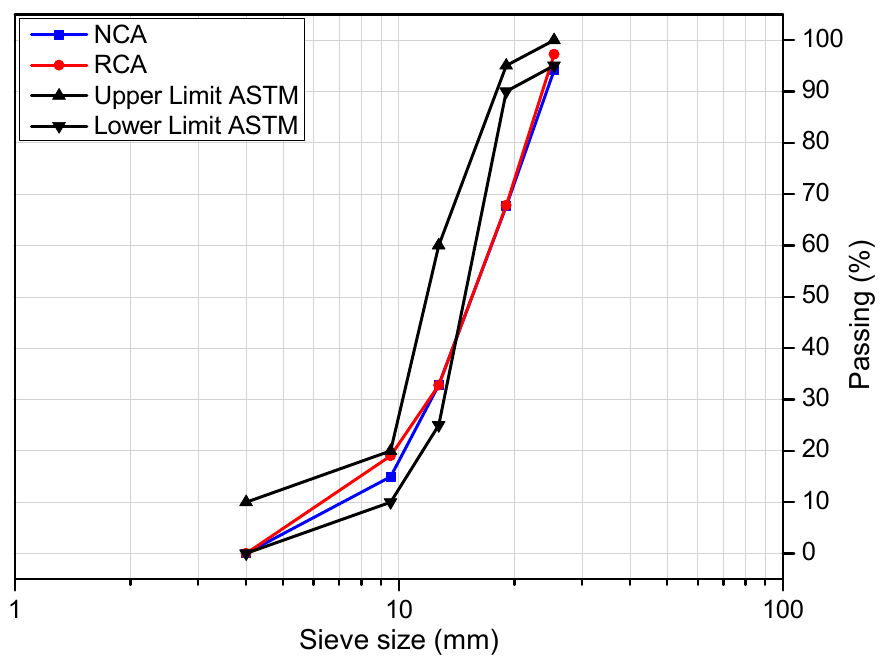
Figure 2. Particle size distribution of coarse aggregates.